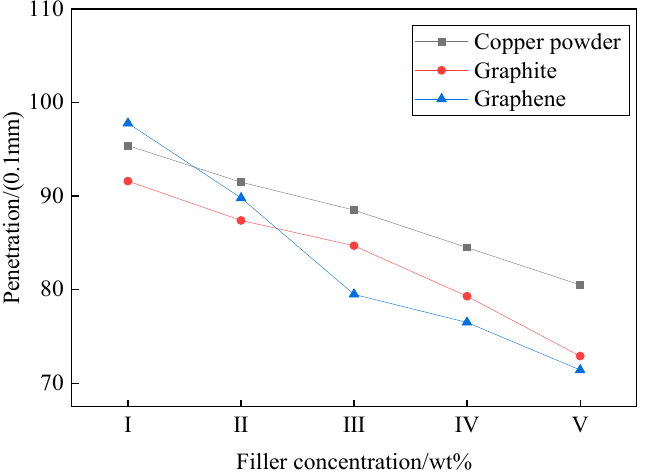
Figure 7. The relationship between penetration and filler content of MEG power complex grease.